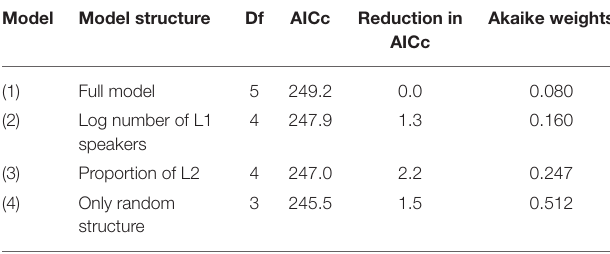
TABLE 7 | Results of model comparison for the reduced model GENDER.ALL. The full model includes both the log number of L1 speakers and the proportion of L2 speakers (including